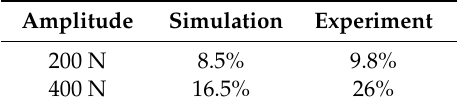
Table 5. Amplitude attenuation with rectangular force